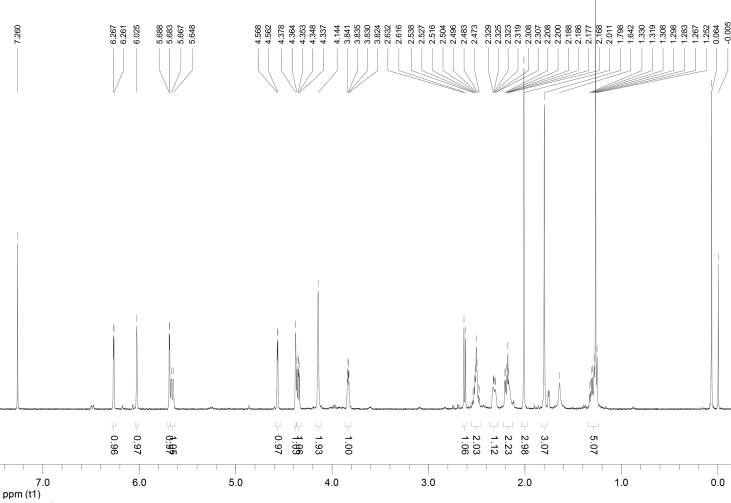
1H NMR (CDCl3) spectrum of compound 5.